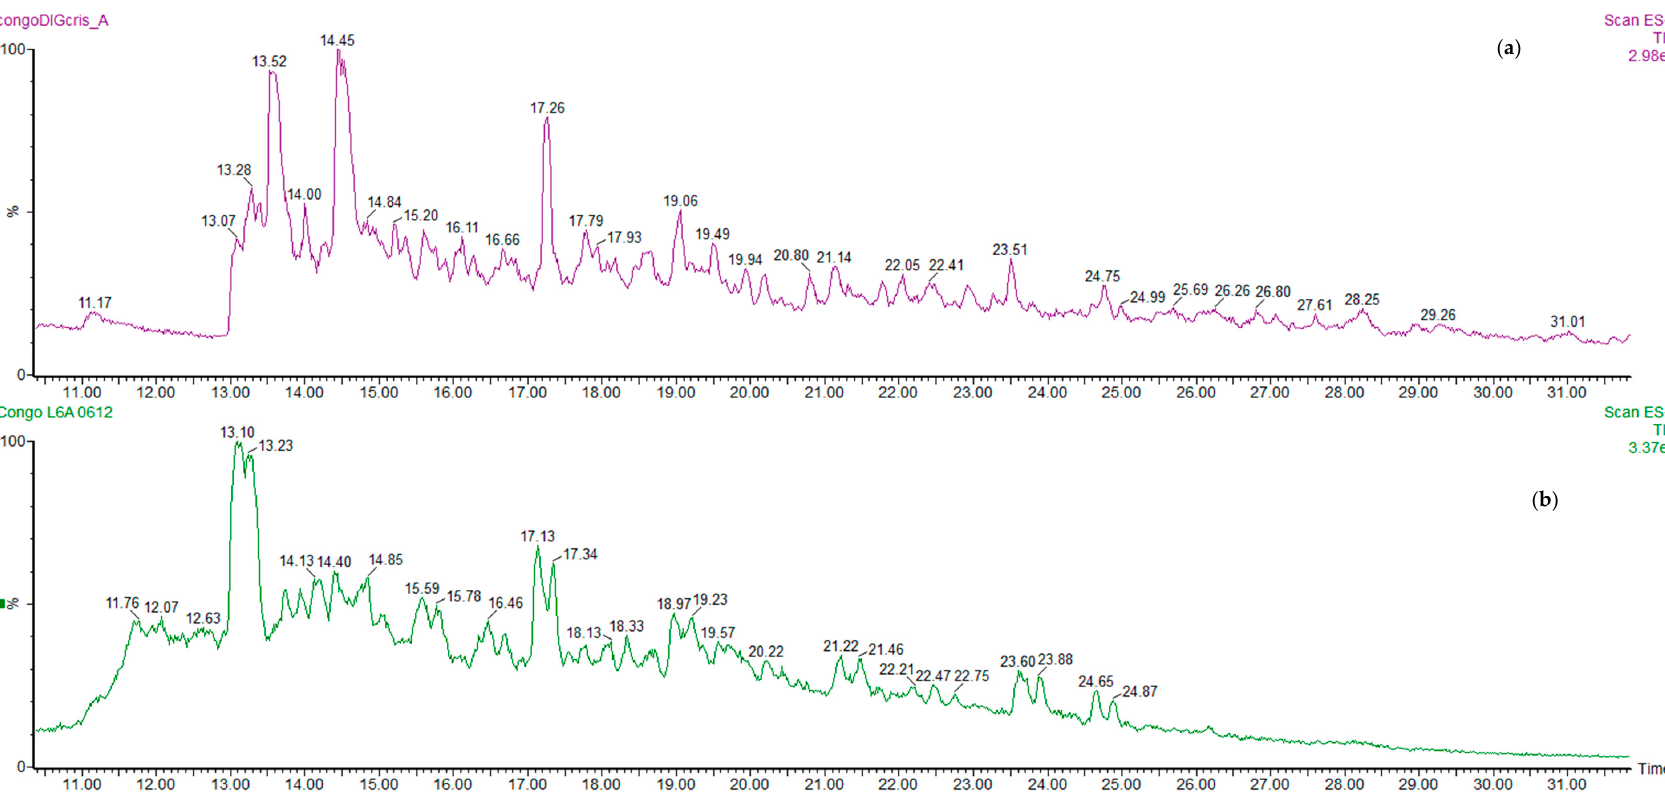
Figure 1. Ultra-high performance liquid chromatography/electrospray ionisation mass spectrometry (UPLC/ESI-MS) chromatogram of a digested sample of Congo fermented cocoa bean ( a ) compared to the peptide profile of the corresponding not digested, extracted sample ( b ).